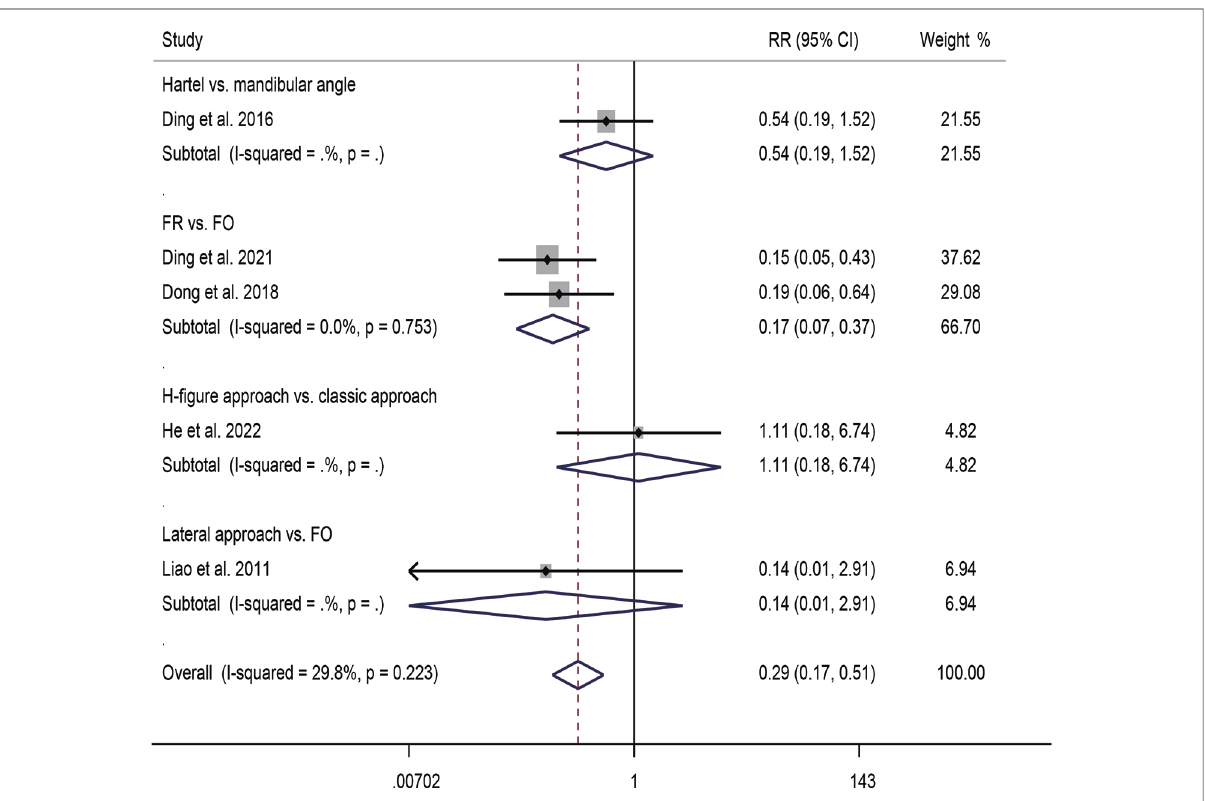
FIGURE 4 Forest plot of complication for the comparison of different puncture approaches (other puncture approaches vs. FO). FO, foramen